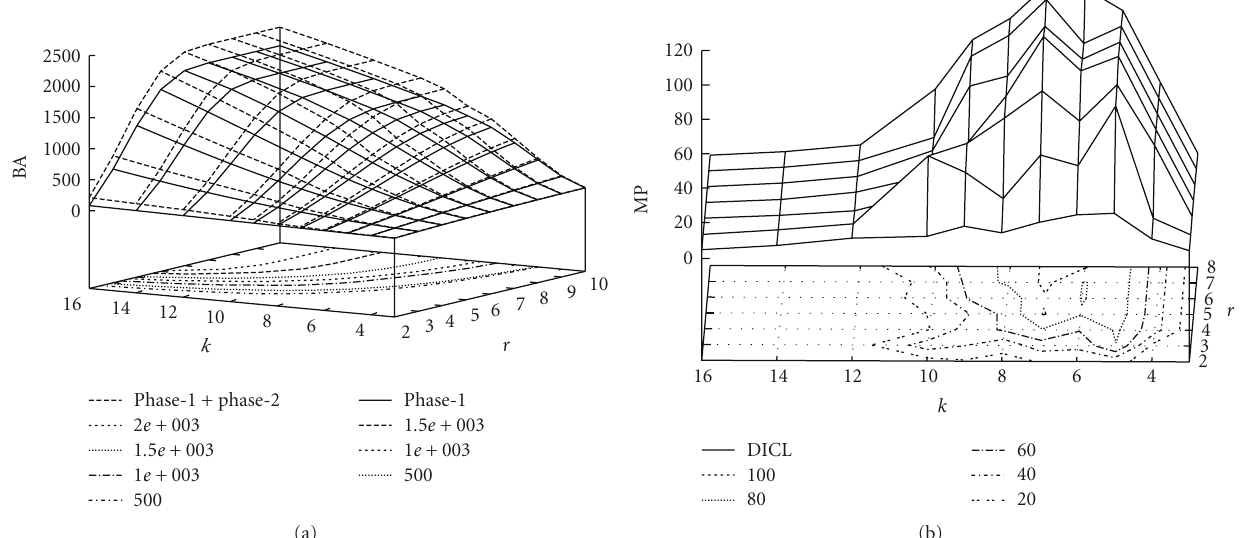
Figure 5: (a) Average amount of data broadcasted in units. (b) Average memory requirements (maximum possibilities per node).